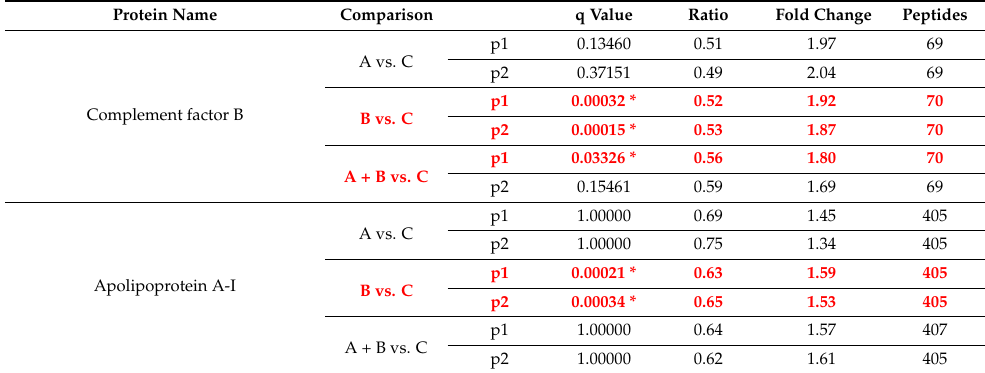
Table 2. Quantitative differences of found